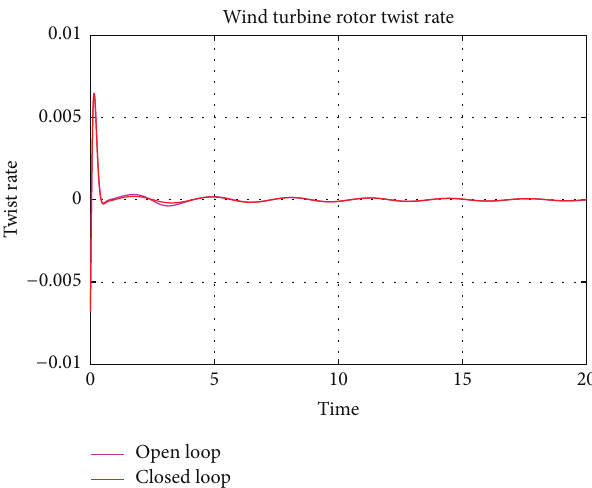
Figure 4: Horizontal axis wind turbine (HAWT) open and closed loop rotor twist rate response.